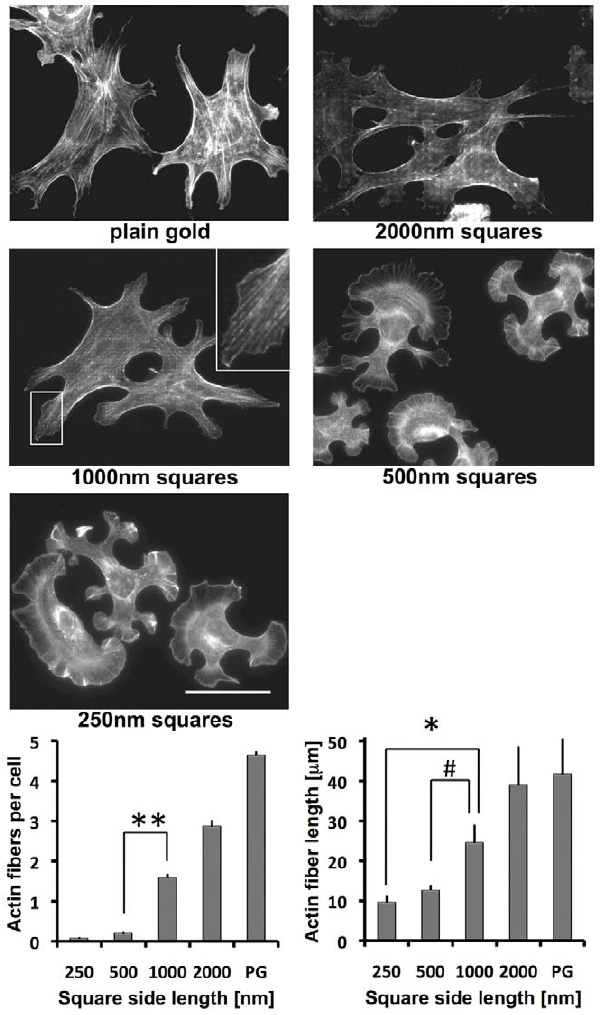
Figure 5. Fibroblasts on RGD- gold squares smaller than 1 m m 2 do not form actin stress fibers. Cells were grown on RGD-coupled gold patterns for 4 hours with 3% fibronectin free serum and subsequently fixed and stained with Alexa-labeled phalloidin. The insert at the upper right of the cells on the 1000 nm pattern is an enlargement of the boxed area. Scale bar is 50 m m. For quantification of stress fibers, a fluorescence intensity threshold was set to distinguish stress fibers from remaining actin structures. Note the increased number (bottom left) and length (bottom right) of actin stress fibers on patterns $ 1 m m 2 and on plain gold (PG). Values indicate the mean 6 S.E.M. from three independent experiments including $ 30 cells per pattern size; **p , 0.01, *p , 0.05, # p=0.056. substrate (Fig. 5, lower panel). The mean length of these structures gradually increased from 10 mm on the 250 nm pattern to 40 m m on plain RGD-gold.